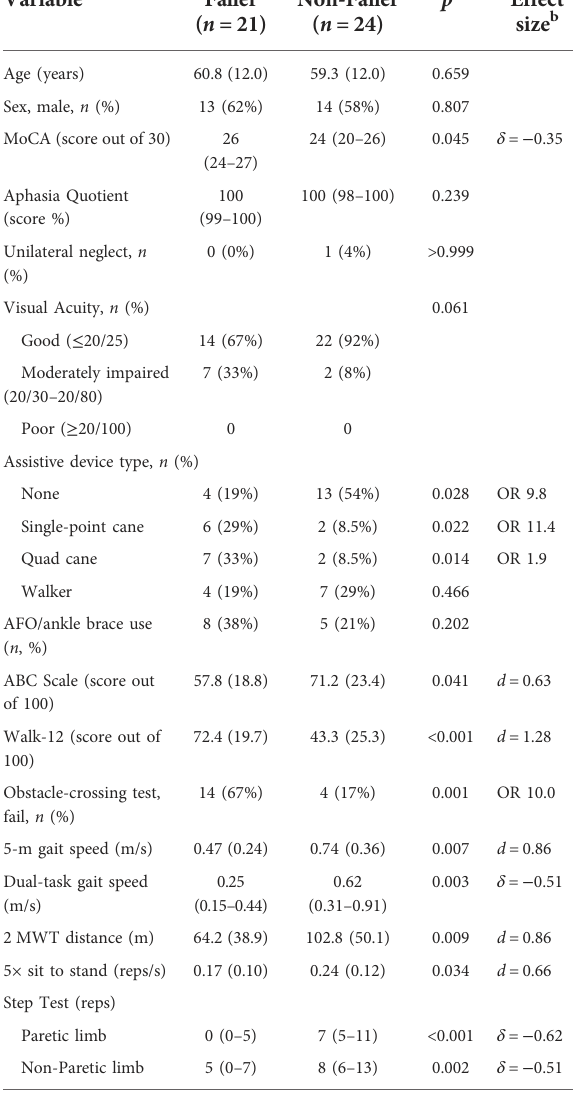
TABLE 2 Comparisons between fallers and non-fallers on biologic (age, sex) and modi fi able variables collected at hospital discharge unless otherwise indicated. Values are n (%) or mean/median (SD/ IQR). Between-group effect sizes for signi fi cant differences only ( α = 0.05) are presented as Cohen ’ s d for normally distributed continuous variables and Cliff ’ s δ for skewed continuous variables. Odds ratios (OR) are the effect sizes for the categorical